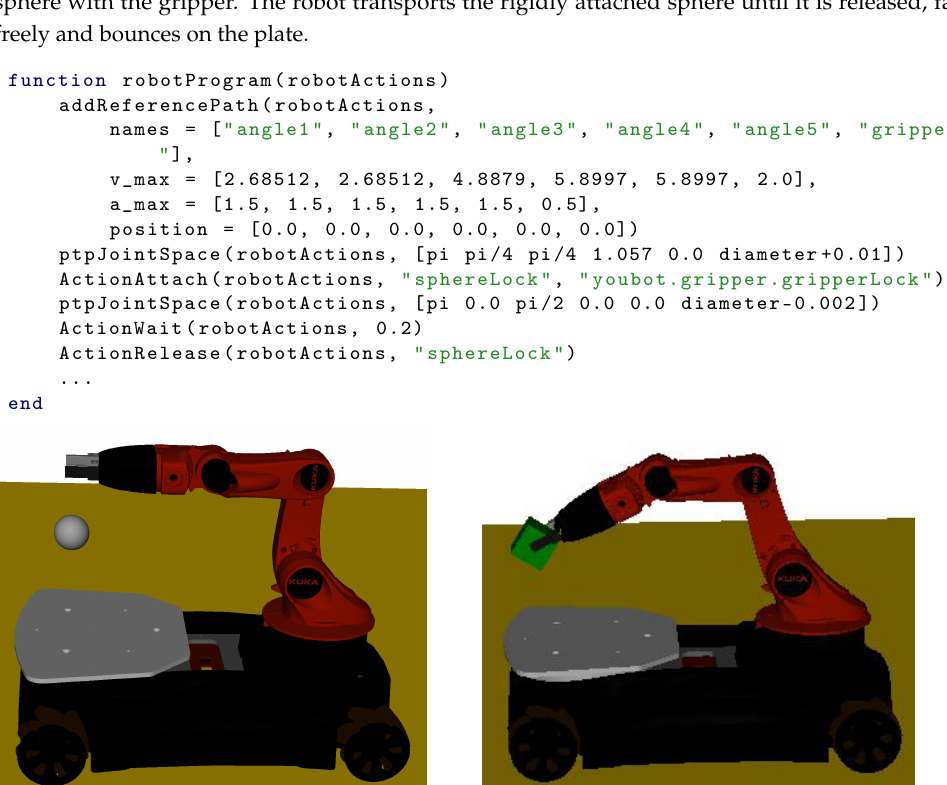
Figure 12. ( Left ) Scenario 1: A YouBot robot after releasing a free falling sphere (six DoF). The sphere will bounce on the grey plate. ( Right ) Scenario 3: A YouBot transporting a box with segmented